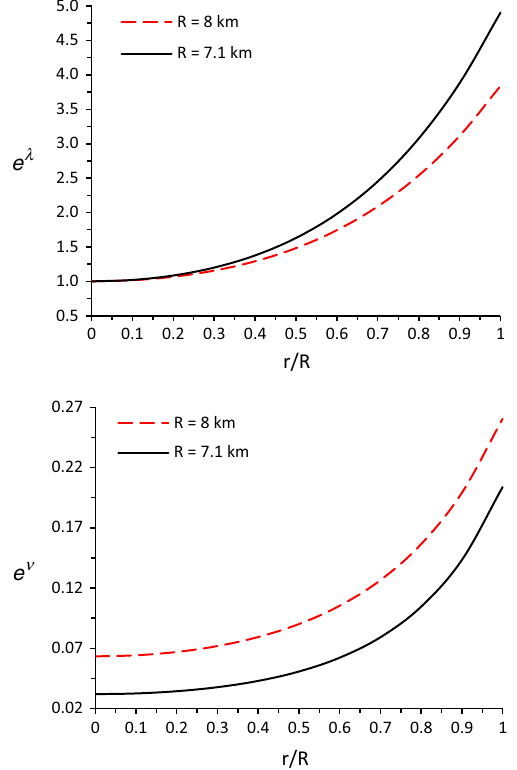
Fig. 1 Behavior of gravitational potentials ( e λ and e ν ) versus radial coordinates r / R . For plotting of this figure, the corresponding values of arbitrary constants or parameters are displayed in Table